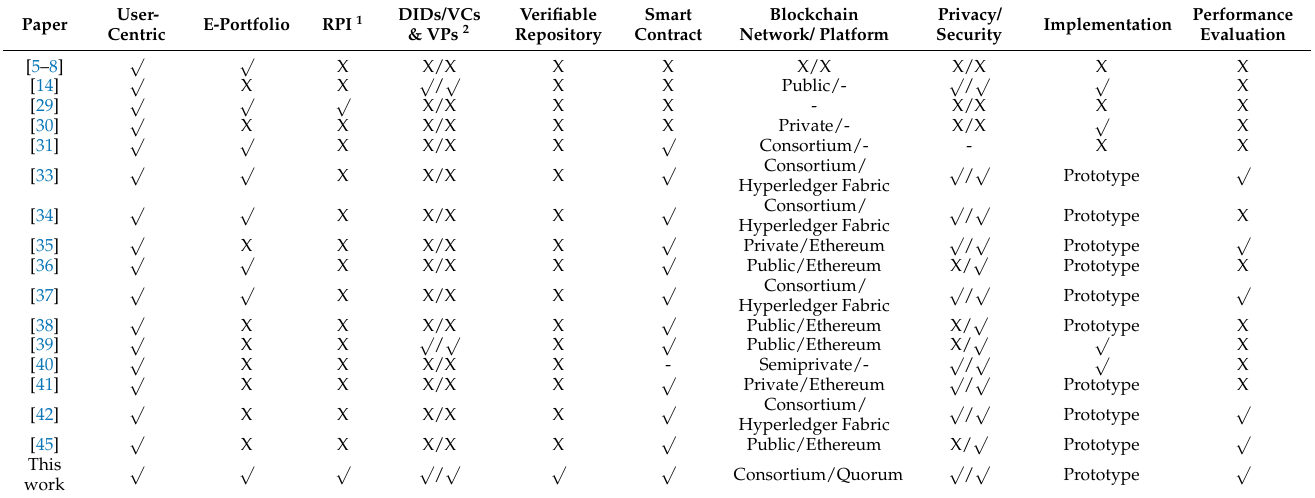
Table 2. Comparison of the proposed scheme with existing works in the